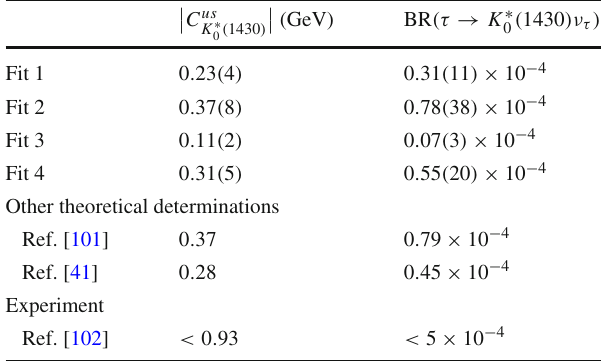
( 1430 ) residue and the corresponding Table 6 Results for the K ∗ 0 τ → K ∗ ( 1430 )ν τ branching fraction, in comparison to the literature. 0 The limit is given at 95% confidence level (cid:23) (cid:23) (cid:23) C us (cid:23) K ∗ 0 ( 1430 )